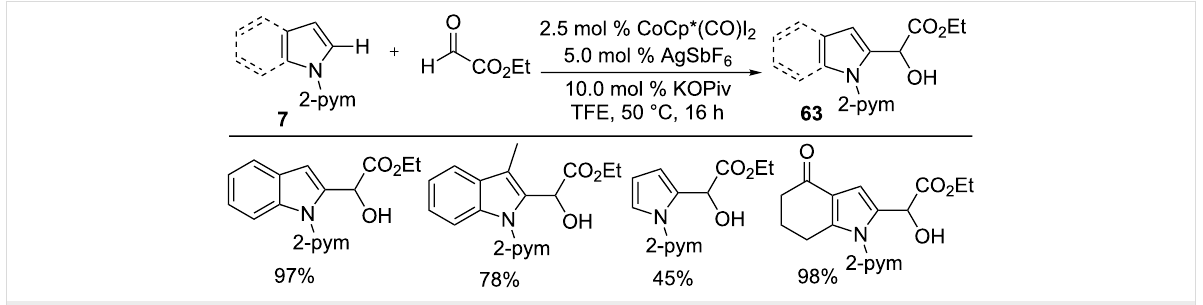
Scheme 40: Co(III)-catalyzed hydroarylation of aldehydes.